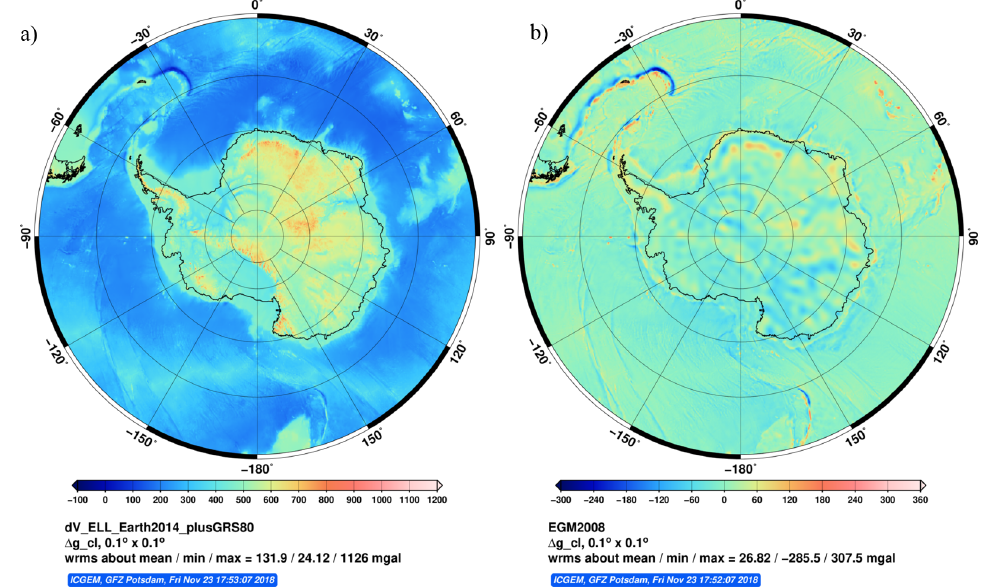
Figure 9. The classical gravity anomalies which are also known as free-air gravity anomalies computed on the Earth’s surface based on (a) the topographic model dV_ELL_Earth2014_plusGRS80 and (b) EGM2008 using the model’s highest degree and order available, 2190. It is clearly seen that the features in Antarctica are better resolved in (a) . Note that the scale is kept as it is for individual cases on purpose since the present forms of the figures are exactly what the ICGEM calculation service